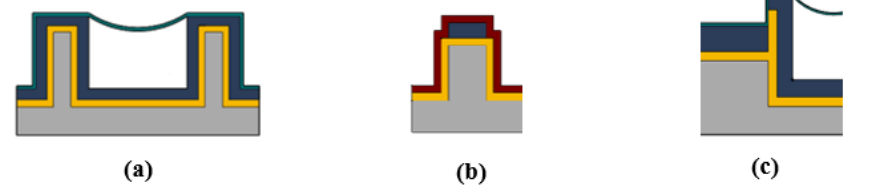
Figure 2. ( a ) Optofluidic channel with suspended nanomembrane. ( b ) Solid core ridge waveguide. ( c ) Interface between solid core ridge waveguide and liquid channel. The interface is thermal silicon dioxide. The ridge waveguide couples light into liquid channel for particle manipulation. Thermal silicon dioxide is shown in gold ( n = 1.44), high refractive index PECVD silicon dioxide is shown in blue ( n = 1.51), low refractive index PECVD silicon dioxide is shown in red ( n = 1.44), PECVD silicon dioxide for the membrane is shown in light blue ( n = 1.51), and silicon is shown in